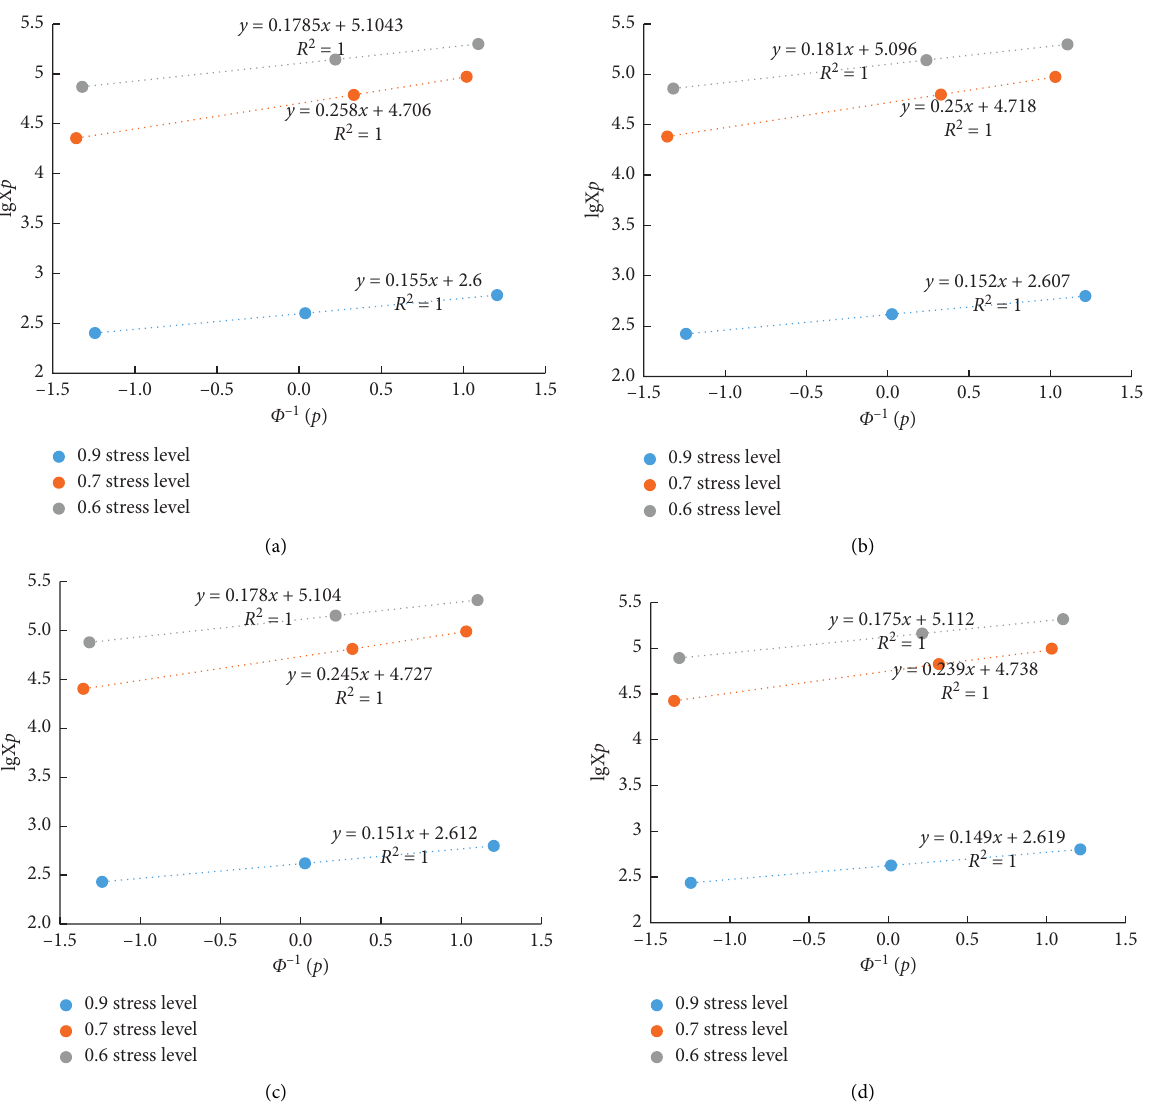
Figure 6: SiCRC linear regression. (a) SiCRC (0d). (b) SiCRC (30d). (c) SiCRC (60 d). (d) SiCRC